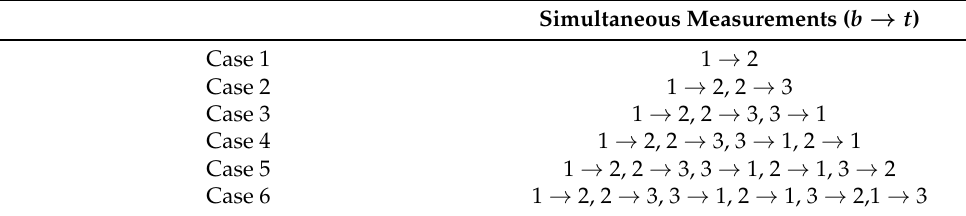
Table 6. Simultaneous measurement descriptions for Scenario 2.